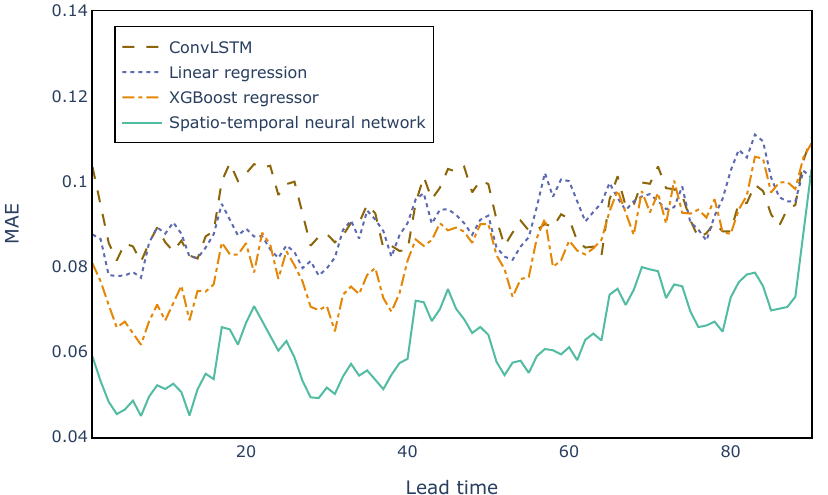
Figure 12. Comparison between the proposed spatio-temporal neural network, linear regression, the XGBoost regressor, and the ConvLSTM network. In particular, MAEs are plotted for each lead time, from 1 to 90.